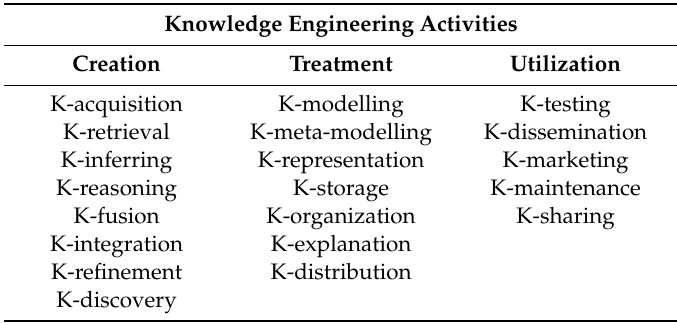
Table 1. A limited overview of the knowledge engineering activities.